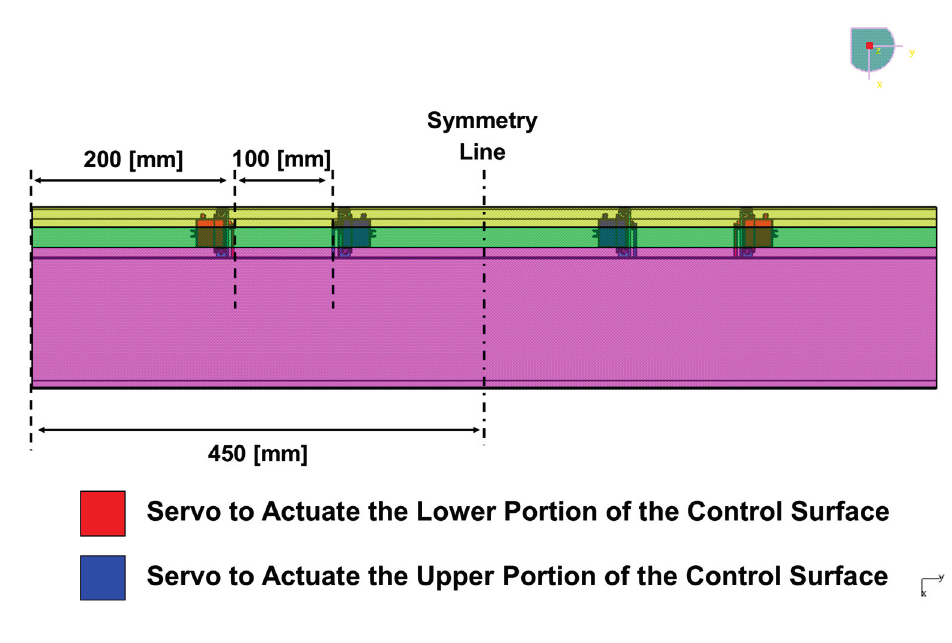
Figure 6. Top view of servo actuators in a four servo actuator